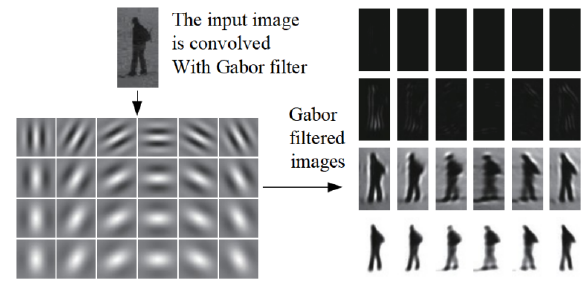
Fig. 5. Gabor feature map with 4 scales and 6 directions dimensional Gabor filter and modulo is taken to obtain two-dimensional Gabor filtered image. Then the filtered image is further analyzed to extract Gabor features.